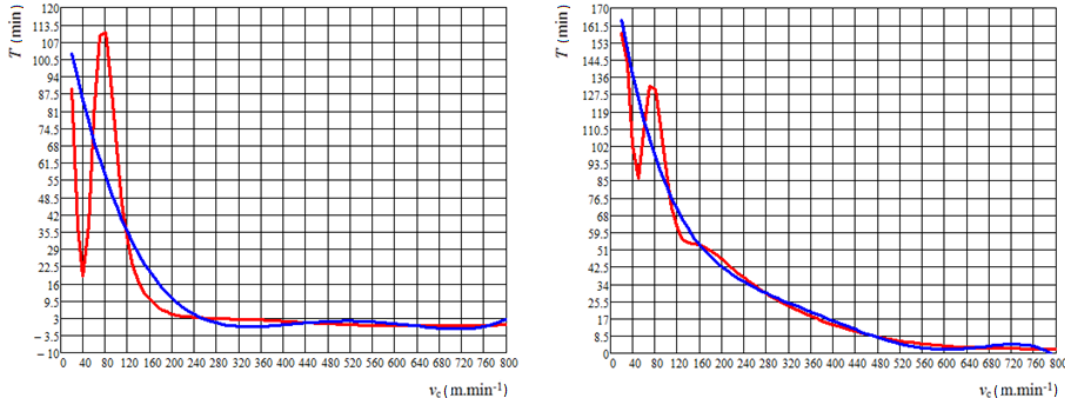
Figure 14. Regression analysis of T-v c dependence for P20 ( left ) and P20 + TiN ( right )—CNC machine (red curve—values obtained from experiment; blue curve—values determined in accordance with ISO 3685).